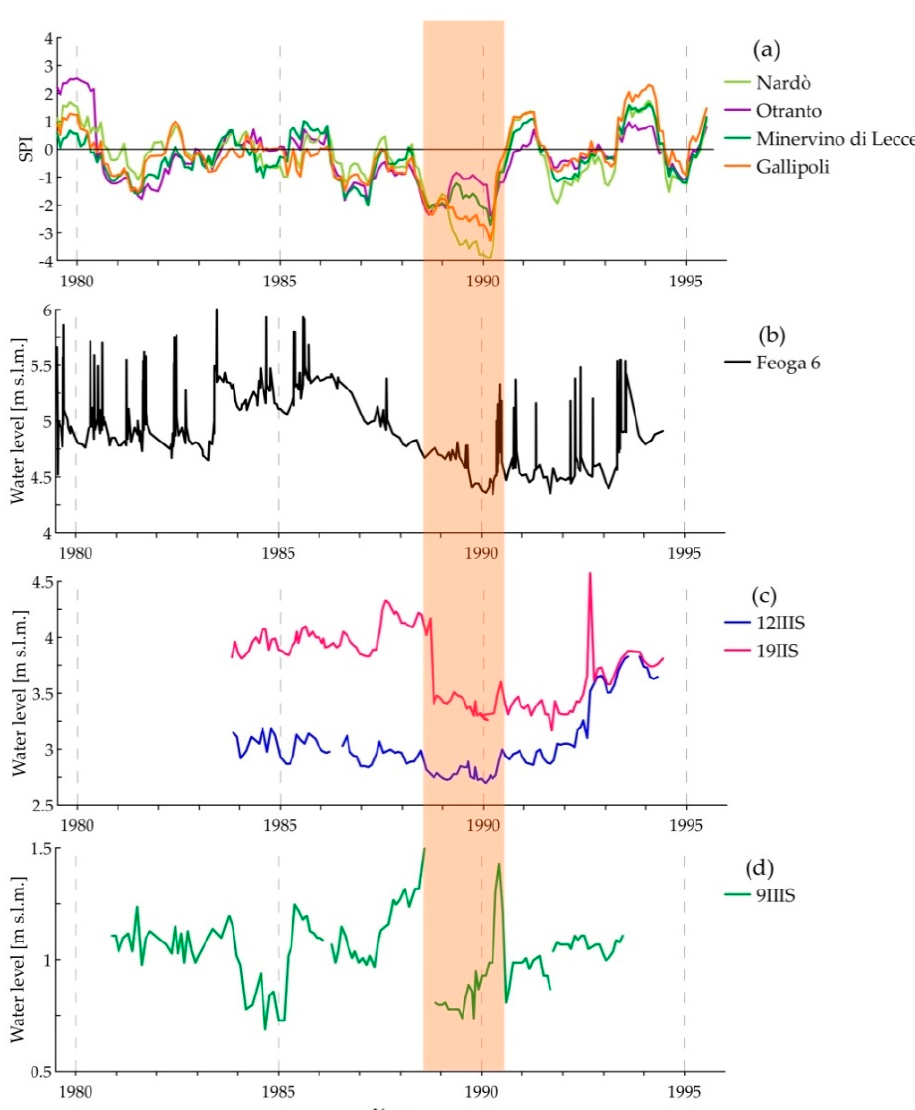
Figure 5. SPI calculated for precipitation measured between 1979–1995 at the Nardò, Otranto, Minervino di Lecce and Gallipoli rain gauge stations ( a ) compared to the water level time series over 1979–1994 of the Feoga-6 ( b ), 12IIIS and 19IIS ( c ), and 9IIS ( d ) MWs respectively. The coloured bar covers the period 1 January 1989–31 December 1990; the date ticks are centred on 1 July of the correspondent year. The location of gauge stations and MWs is in Figure 3.